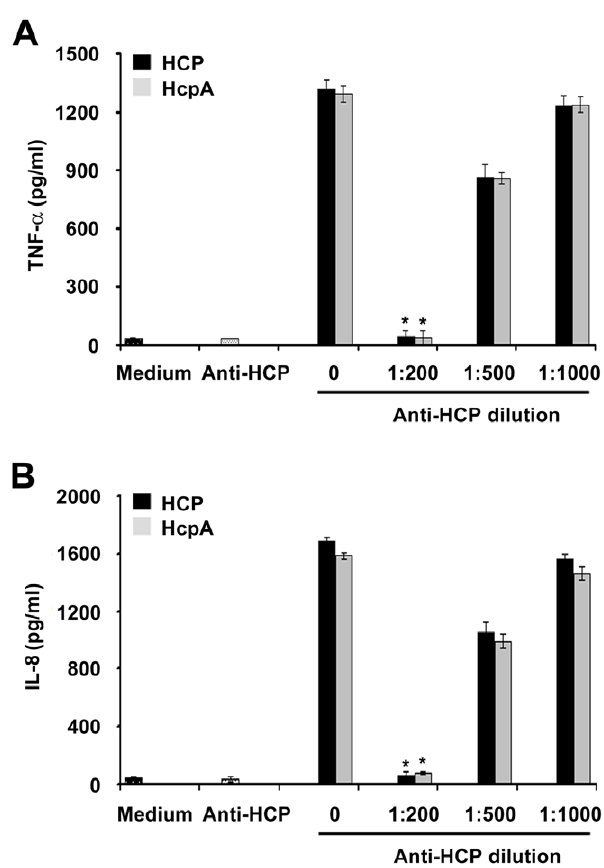
Figure 7. Anti-HCP antibodies blocked the secretion of proinflammatory cytokines. Purified HCP or HcpA protein (100 pg/ml) were pre-incubated with anti-HCP antibodies in DMEM low glucose medium before addition to the apical surface of HT-29 cells. A dose-dependent inhibition for IL-8 and TNF- a from HT-29 cells was obtained: between 95–98% at the 1:200 dilution of the antibody (A and B). * P , 0.0002.